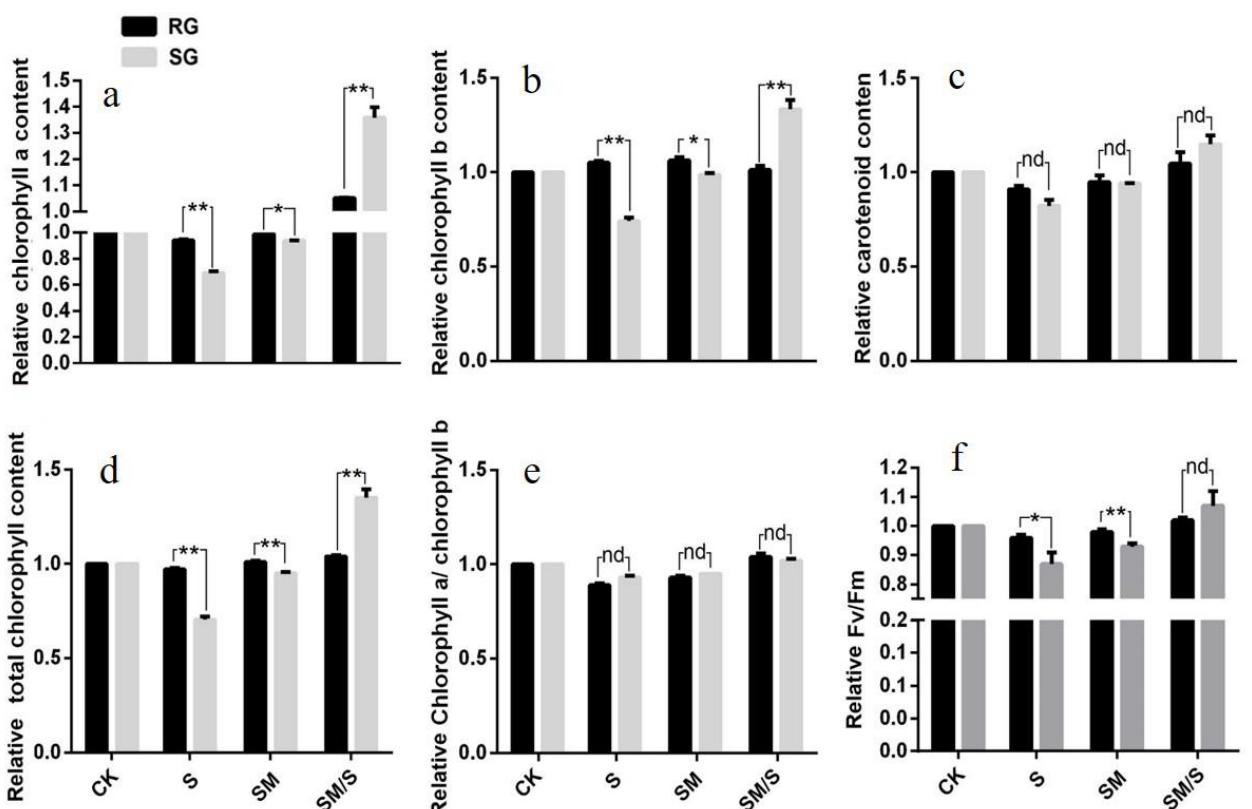
Figure 5. Comparison of pigment content and chlorophyll fluorescence, including relative chlorophyll a content ( a ), relative chlorophyll b content ( b ), relative carotenoid content ( c ), relative total chlorophyll content ( d ), relative chlorophyll a/chlorophyll b ( e ), and Fv/Fm ( f ) between salt-resistant and salt-sensitive tomato seedlings under salt stress. All the indices normalized to CK. RG: salt-resistant genotype; SG: salt-sensitive genotype; CK: 1/2 Garden nutrient solution of Japan (GNSJ) + spraying distilled water; M: GNSJ + spraying 100 μM melatonin; S: GNSJ -NaCl (containing 200 mM NaCl) + spraying distilled water; SM: GNSJ- NaCl (containing 200 mM NaCl) + spraying 100 μM melatonin. The asterisk indicates significant difference detected by Student’s t -test ( p < 0.05 marked with * and p < 0.01 marked with **). nd: no difference. Mean ± SE were given (n = 3, biological repli-